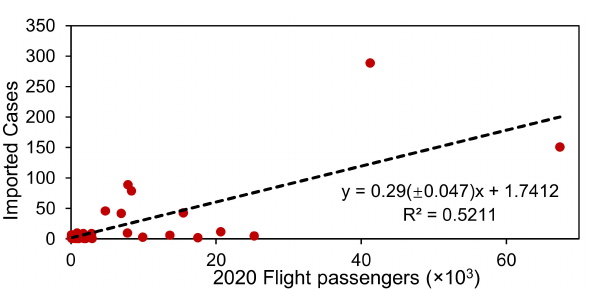
Figure A1. Imported cases in relation to number of inbound airline passengers in China, excluding low-risk countries namely, Thailand, Japan, and Cambodia.